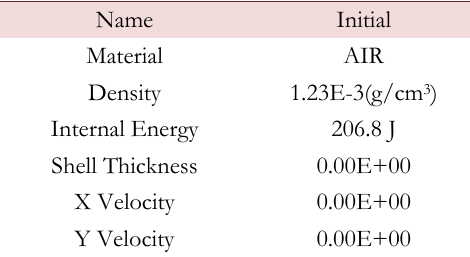
Table 3: Initial condition for air as a Euler